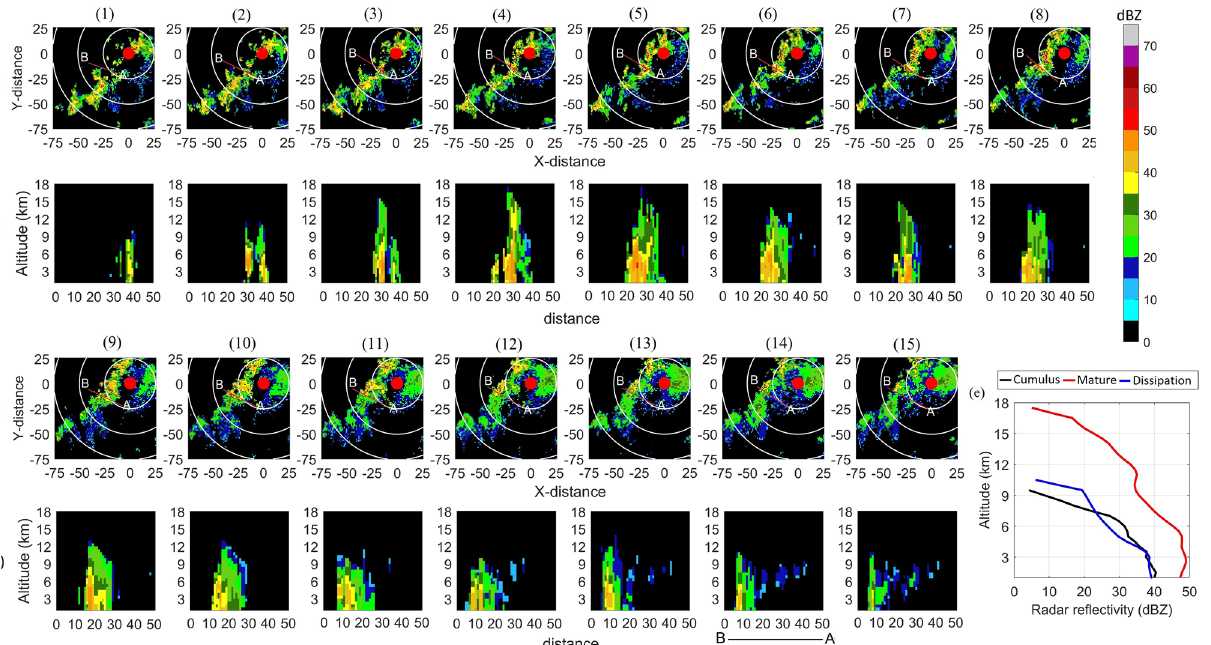
Figure 2. Temporal evolution of a storm observed on 17 September 2016 over the Bhopal region before the cumulus phase (1510 IST, top left panel) till the time instant after the dissipation (1732 IST, bottom most right) phase. The panels in rows ( a ) and ( c ) are the composite reflectivity patterns, and rows ( b ) and ( d ) are the vertical sections taken across the storm along line BA. Successive panels from left to right are 10 min apart. Panel ( e ) shows the VPRRs at cumulus, mature, and dissipation phases. The color bar is Z e in the dBZ